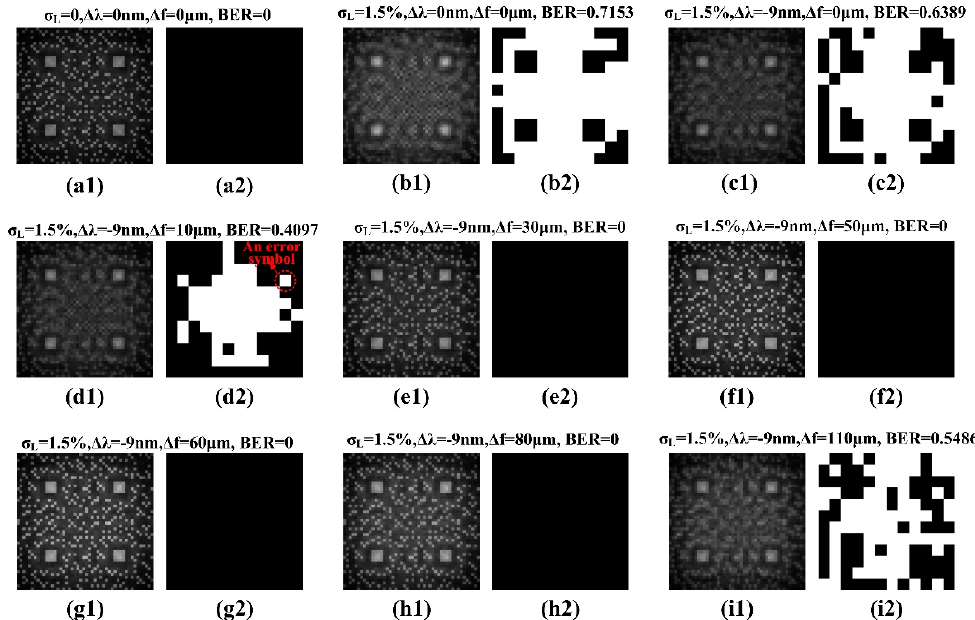
Figure 8. ( a ) The reconstructed signal pattern without the dimension change of the recording medium; ( b ) the reconstructed signal pattern with σ L = 1.5% and without any compensation. When σ L = 1.5%, for the reconstructed signal patterns with the combination compensation method, the reading light wavelength was decreased by 9 nm and the focal length was changed by ( c ) 0 μ m, ( d ) 10 μ m, ( e ) 30 μ m, ( f ) 50 μ m, ( g ) 60 μ m, ( h ) 80 μ m and ( i ) 110 μ m. The corresponding symbol error diagrams are depicted to the right of the correlated reconstructed signal patterns.